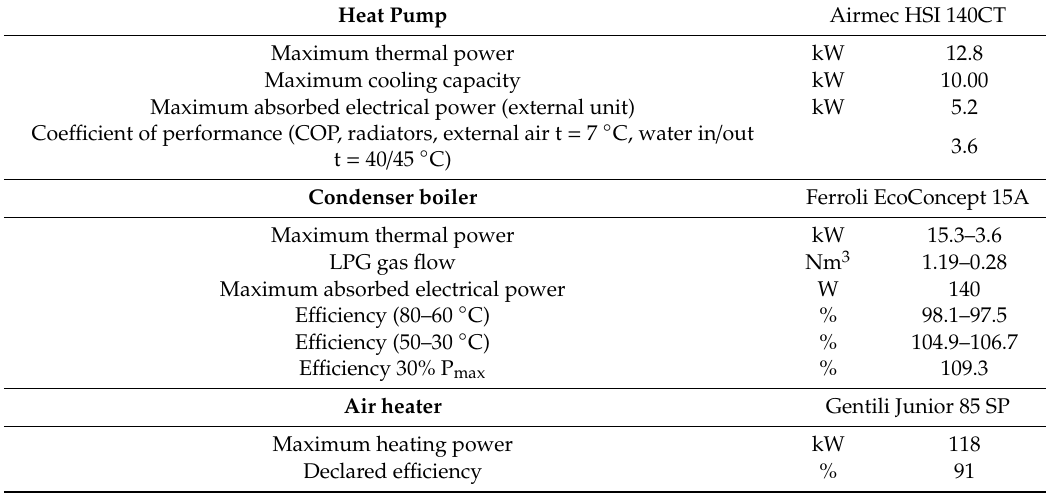
Table 2. Technical declared data of the three heating